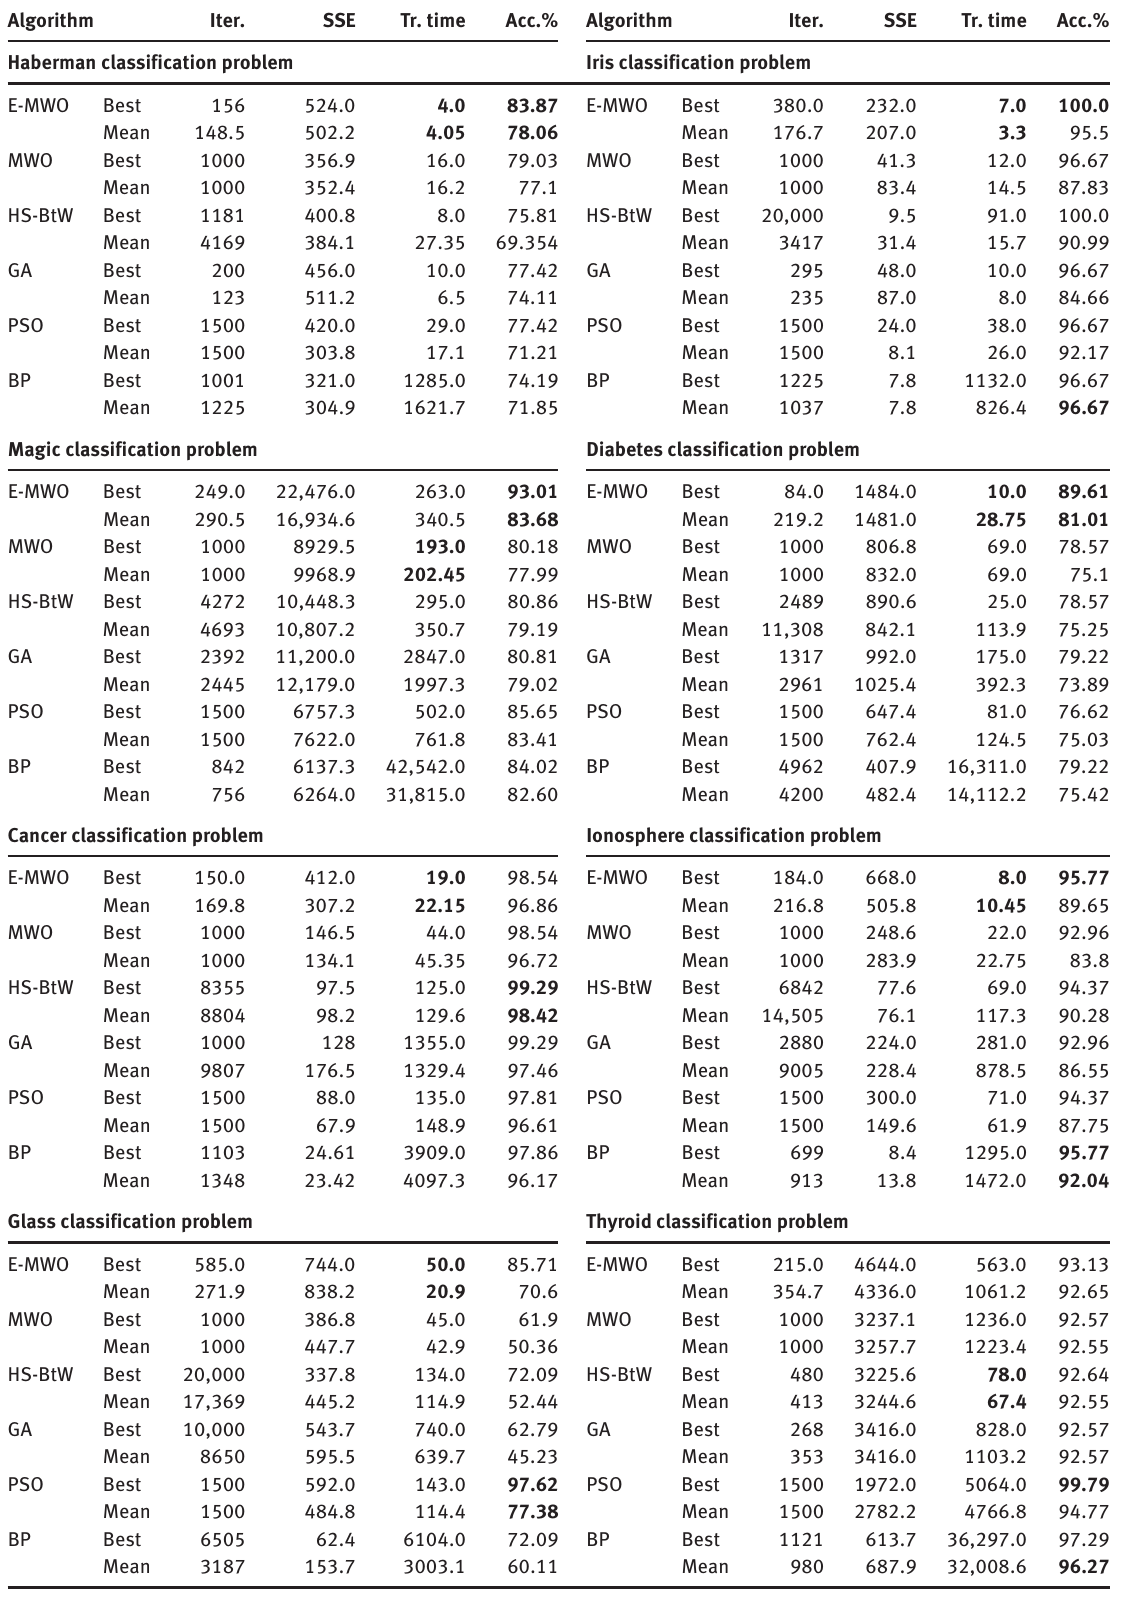
Table 6: Benchmark Classification Problems’ Results for 20 run.